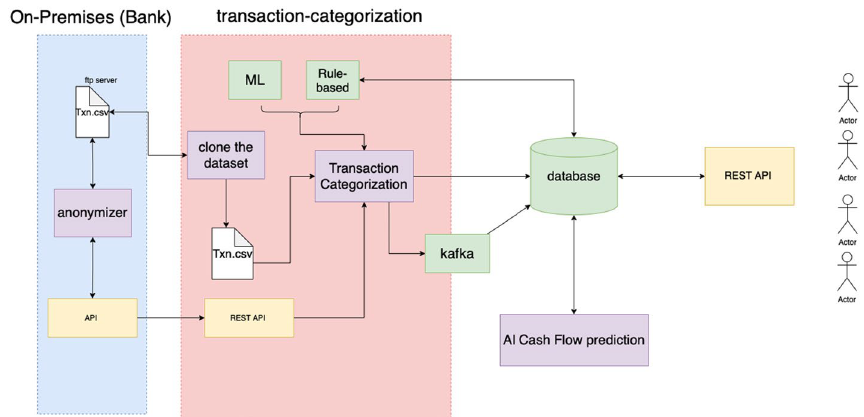
Fig. 5 Logical view of the connected components of the framework including transaction categorization and cashflow